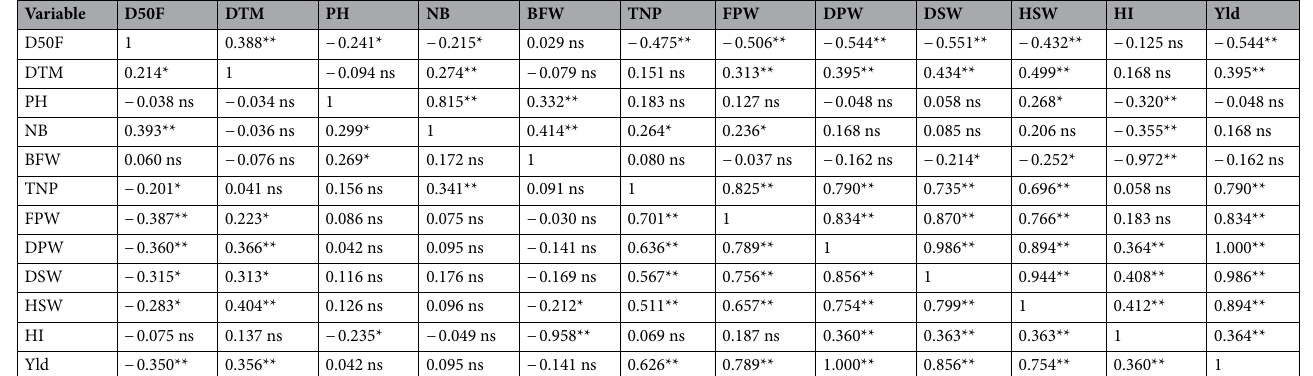
Table 6. Assessment of phenotypic correlation (above diagonal) and genotypic correlation (bellow diagonal) among 12 characters of V. subterranea genotypes. * = Significant (p ≤ 0.05),** = Highly significant (p ≤ 0.05),